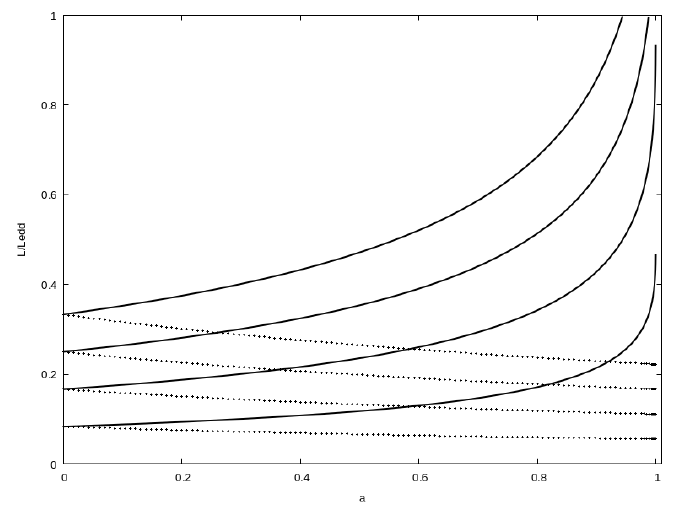
Figure 2. Profiles of luminosity (in terms of Eddington luminosity L Edd ) for both retrograde BHs (dotted lines) and prograde Kerr BHs (full lines) as functions of the black hole spin a